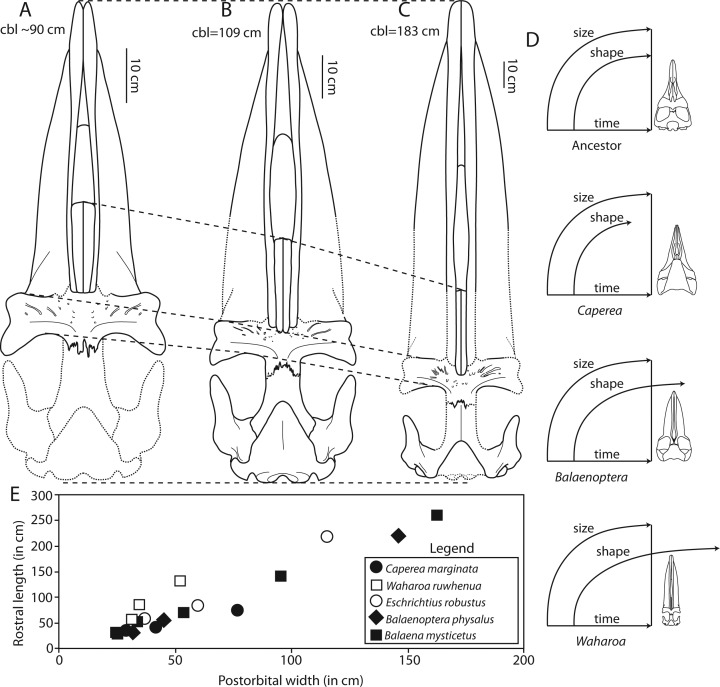
Rostral ontogeny in Waharoa ruwhenua.Comparison of relative proportion of temporal fossa, cranium length, nasal length, and condylobasal length in (A) small juvenile (OU 22075); (B) large juvenile (OU 22163), and (C) adult (OU 22044). (D) ontogenetic clock models of hypothetical archaeocete ancestor, Caperea, Balaenoptera, and Waharoa, modified from Tsai & Fordyce (2014a). (E) Relation between rostrum length and postorbital width in Balaena, Balaenoptera, Caperea, Eschrichtius, and Waharoa.